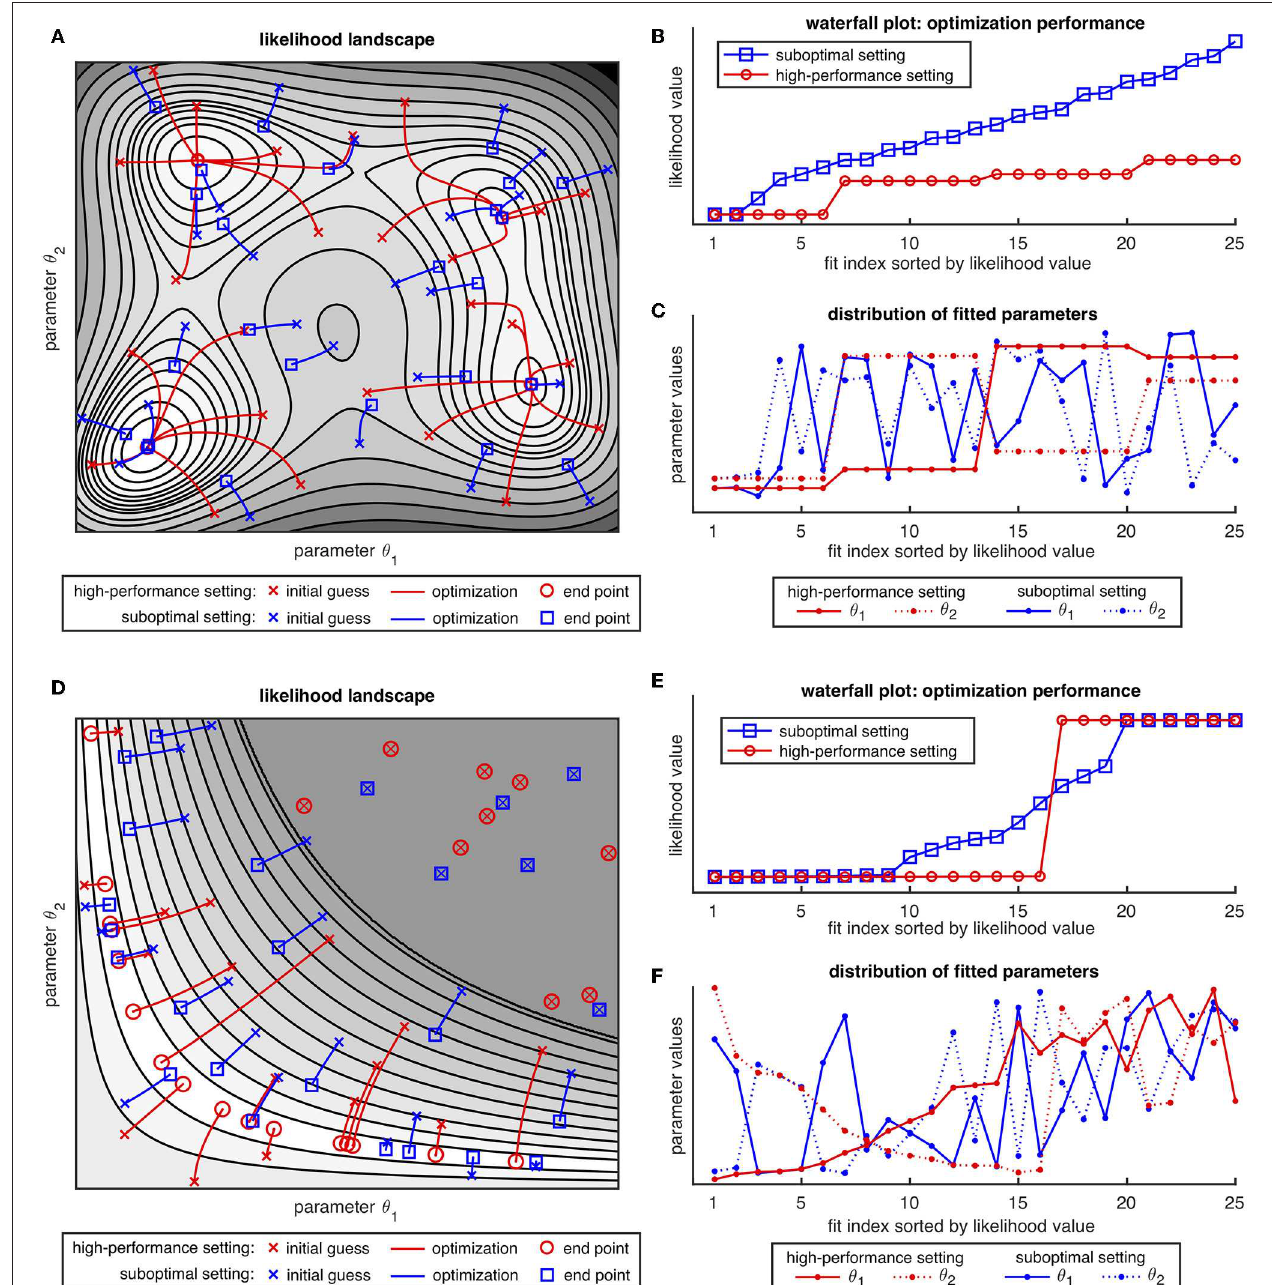
FIGURE 2 | Illustrative likelihood landscapes in (A,D) and resulting waterfall plots in (B,E) with their respective parameter distributions plots in (C,F) . A high-performance setting is plotted in red, whereas a suboptimal optimization setup is realized by restricting the maximal number of iterations and depicted in blue.